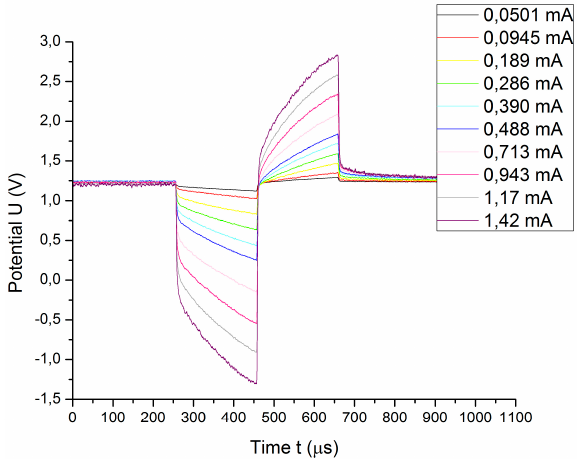
Figure 11. Potential transients of electrode B obtained by applying charge-balanced biphasic symmetric pulses with different current amplitudes and 200 µs pulse width.